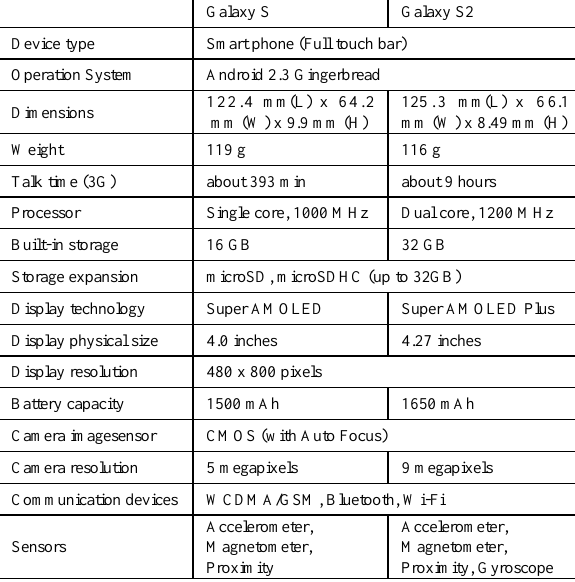
Figure 1. Diagram of the smartphone-based photogrammetric UAV system. Table 1. Technical specification of Samsung Galaxy S and S2 (Samsung mobile, 2012a, 2012b)